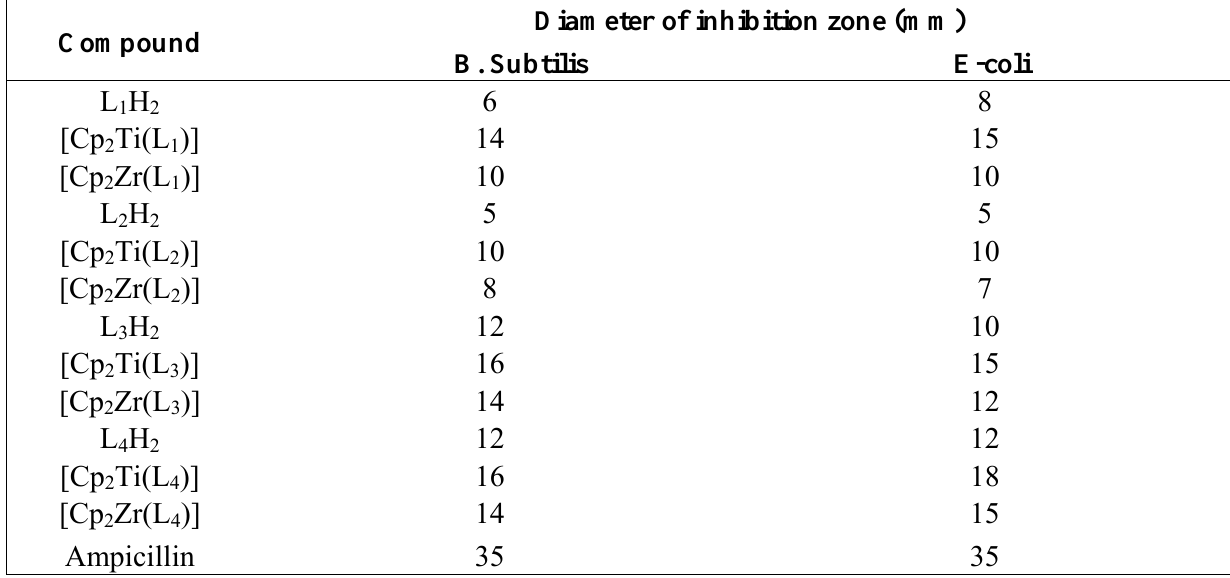
Table 3 – Antibacterial activity of imine – oxime ligands and their